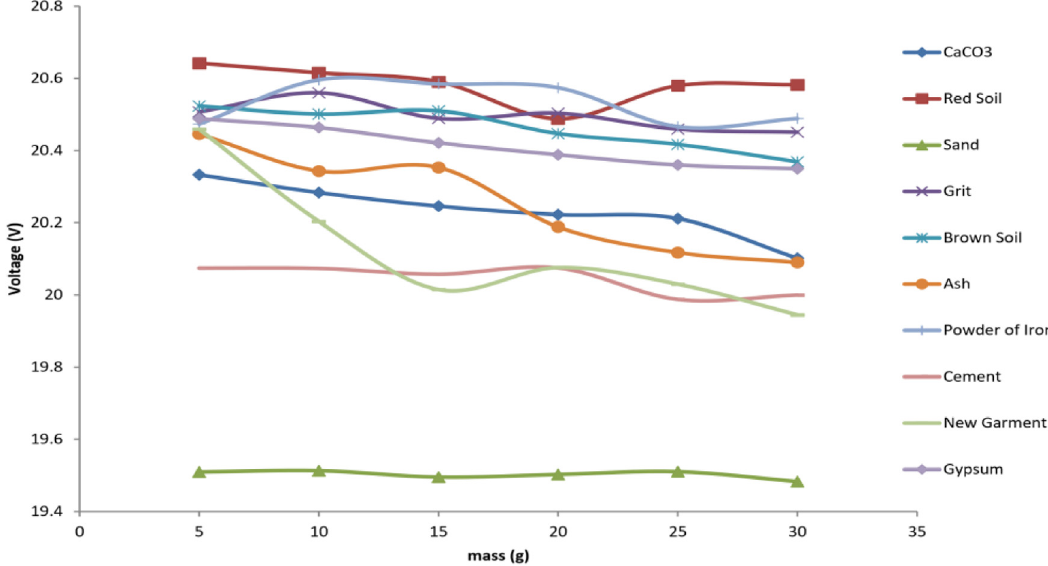
Fig. 3. Effect of changing the weight of the studied impurities accumulated on the voltage of PV